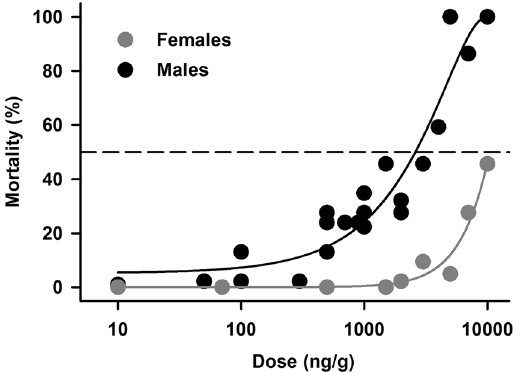
Figure 1. Percent mortality at 48 hours for male and female locusts after injection with imidacloprid (IMD) solutions ranging in concentrations from 10 to 10,000 ng/g (plotted on log scale), fitted with iterative non- linear regressions (solid lines). Points represent proportions from groups of 6 to 12 locusts, normalized to the mortality of vehicle control groups used on each testing day. Regression lines revealed an LD50 of approximately 2,500 ng/g for males. The LD50 for females was beyond the highest concentration